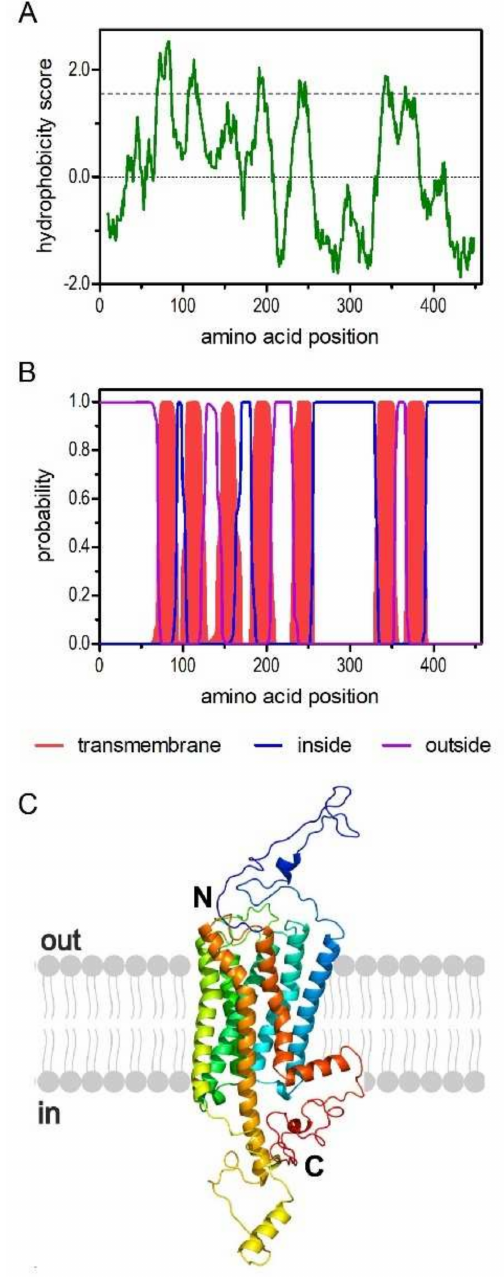
Figure 1. Structural characteristics of the amino acid sequence deduced for PaOct β 2R. ( A ) Hydropho- bicity profile of PaOct β 2R. The profile was calculated according to Kyte and Doolittle algorithm [32] using a window size of 19 amino acids. Peaks with scores greater than 1.6 (dashed line) indicate possible transmembrane regions. ( B ) Prediction of transmembrane domains with TMHMM server v. 2.0 [33]. Putative transmembrane domains are indicated in red. Extracellular regions are shown with a purple line, intracellular regions with a blue line. ( C ) Color-coded (rainbow) 3D model of the receptor as predicted by Phyre2 [34]. The extracellular N-terminus (N) and the intracellular C-terminus (C) are